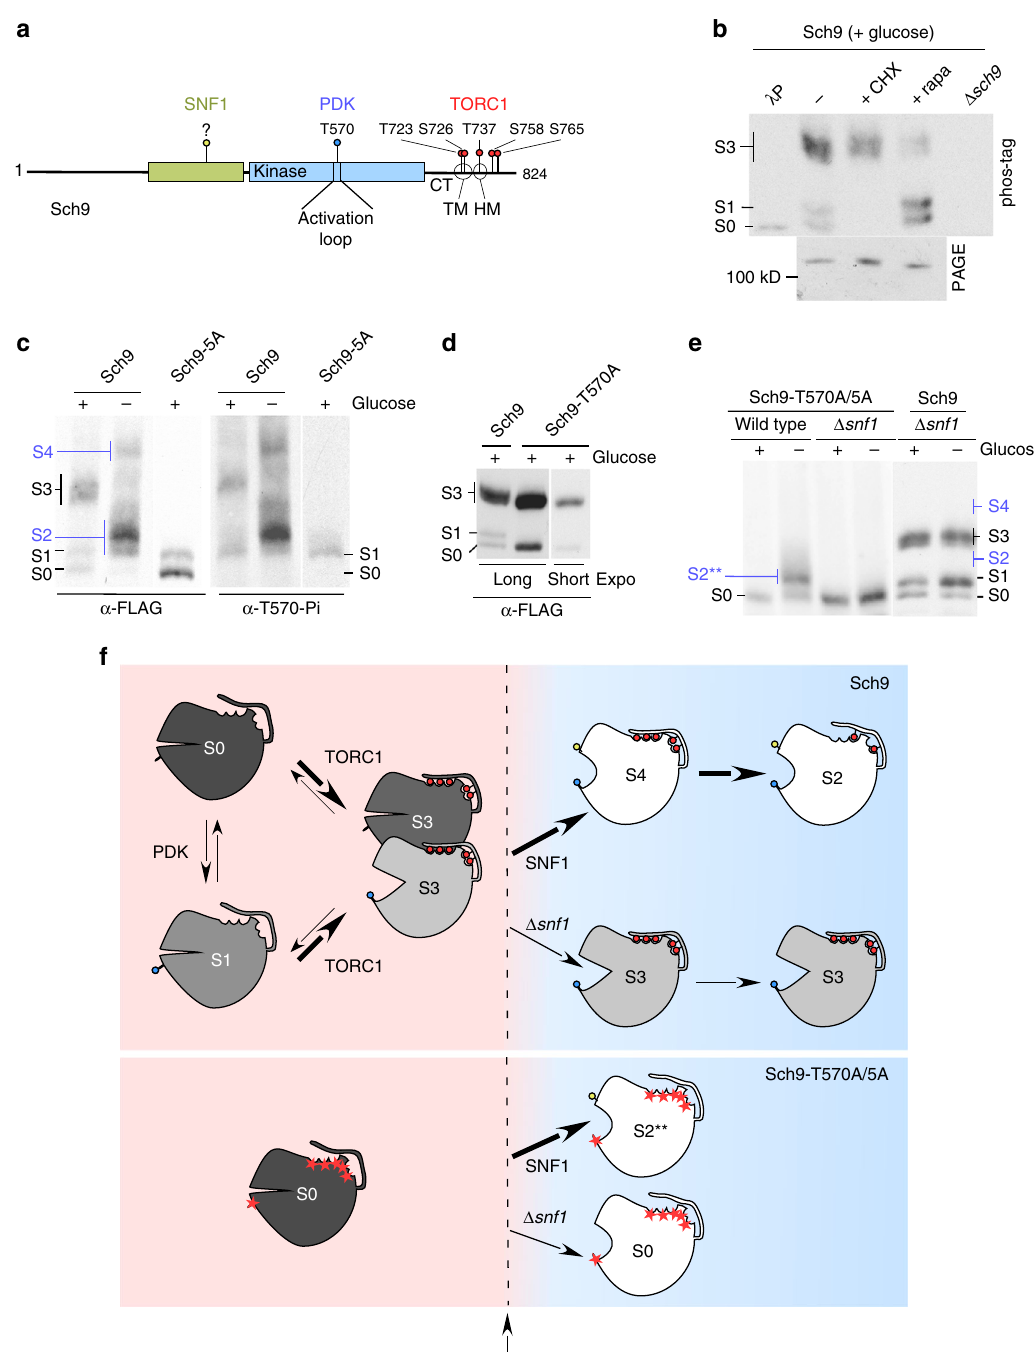
Fig. 1 Phosphorylation pattern of full length Sch9 in glucose-rich and glucose-starved conditions. a Domain structure and phosphorylation sites of the AGC family kinase Sch9. TORC1 targets residues within the C-terminal domain (CT): T723 and S726 are located in a region, which resembles the turn motif (TM) of AGC kinases, T737 is located in the conserved hydrophobic motif (HM), which serves as the docking site for PDK, S758 and S765 are located in HM-like regions 46,49 . These 5 TORC1-dependent sites were changed to alanines in the Sch9-5A mutant or to glutamate/aspartate in the Sch9-2D3E mutant 24 . PDK targets residue T570 within the activation loop 24 . SNF1 targets poorly characterized residues within a region of unknown function 60,61 . b – e Glucose-grown Δ sch9 cells expressing Sch9-FLAG, Sch9-5A-FLAG, Sch9-T570A-FLAG or Sch9-T570A/5A-FLAG were treated with cycloheximide (+CHX), rapamycin (+rapa), or were starved 10min for glucose as indicated. Total protein extracts were resolved on phos-tag or Tris-Tricine (PAGE) gels and were subsequently analyzed via immunoblotting with α -FLAG or α -phospho-T570 ( α -T570-Pi) antibodies. If indicated, total extract was treated with lambda phosphatase ( λ P) prior to the analysis. Sch9 species prominent on glucose (S0, S1, S3) are indicated in black, species prominent after starvation are indicated in blue (S2, S4, S2**). f Cartoon summary of Sch9 phosphorylation. In glucose-rich conditions Sch9 is distributed between S0, S1, and S3. In glucose-starved conditions Sch9 is distributed between S4 and S2. Sch9-T570A/5A is non-phosphorylated in glucose-rich conditions (S0) and becomes phosphorylated at a single residue upon starvation (S2**). The kinases responsible for the respective phosphorylation events are indicated. PDK-dependent phosphorylation, blue circle ; TORC1-dependent phosphorylation; red circles ; SNF1-dependent phosphorylation, yellow circle ; residues mutated to alanines are indicated by red asterisks . For more details compare Results